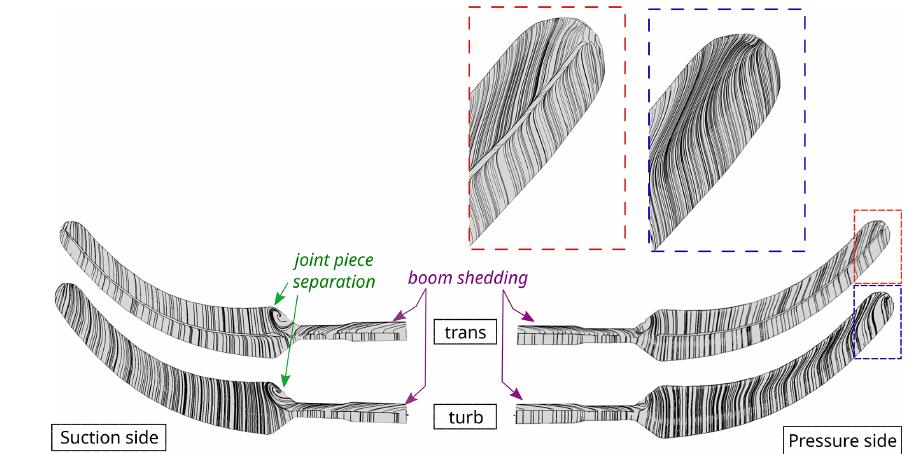
Figure 16. Surface-restricted stream lines computed with the CFD method for case 3 corresponding to a pitch of − 5 ◦ . Both trans and turb results are presented based on the solution of the last computed time